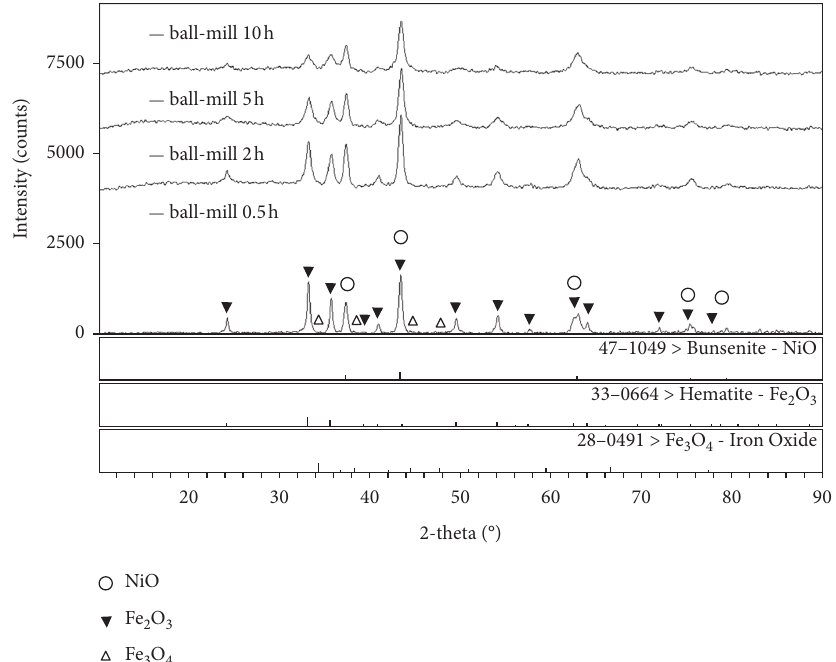
Figure 3: XRD diffraction patterns of the ball-milled powders with different milling